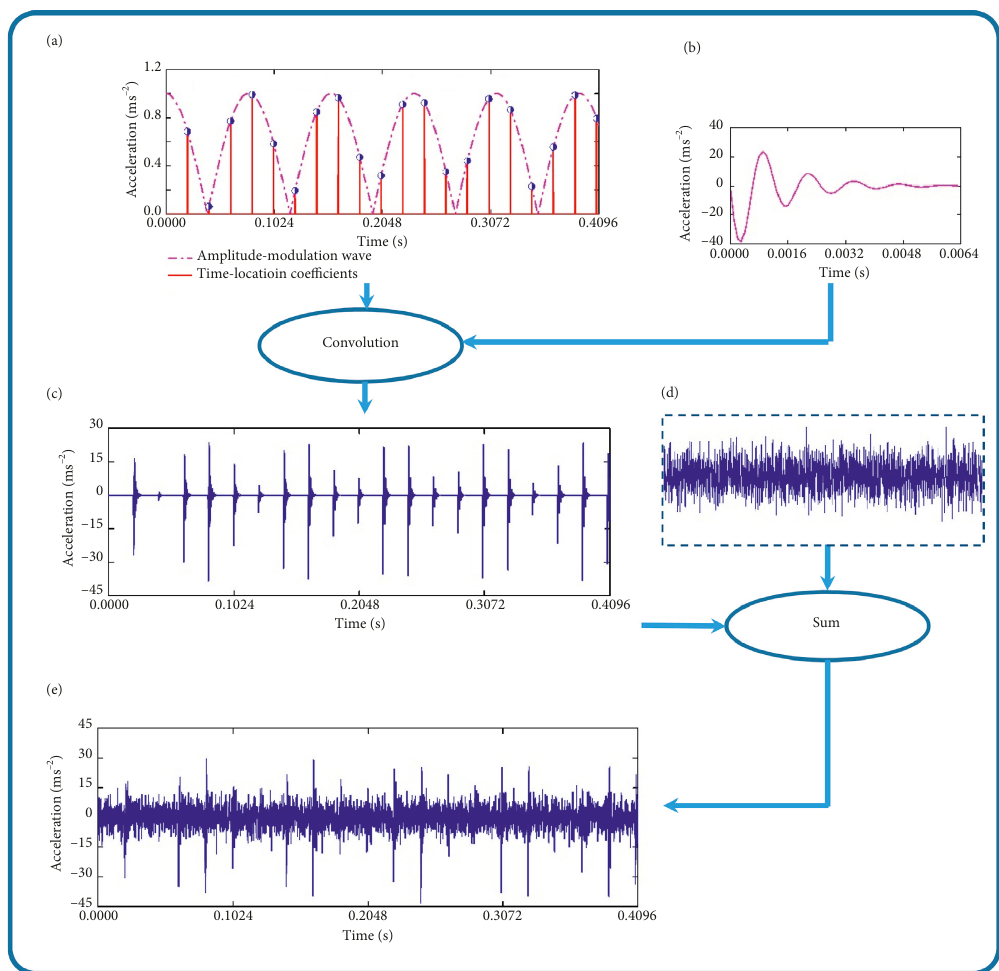
Figure 1: Convolutional representation model of impulse response series. (a) Time-location coefficients. (b) An impulse response. (c) IRS. (d) Measured noises. (e) Measure-version